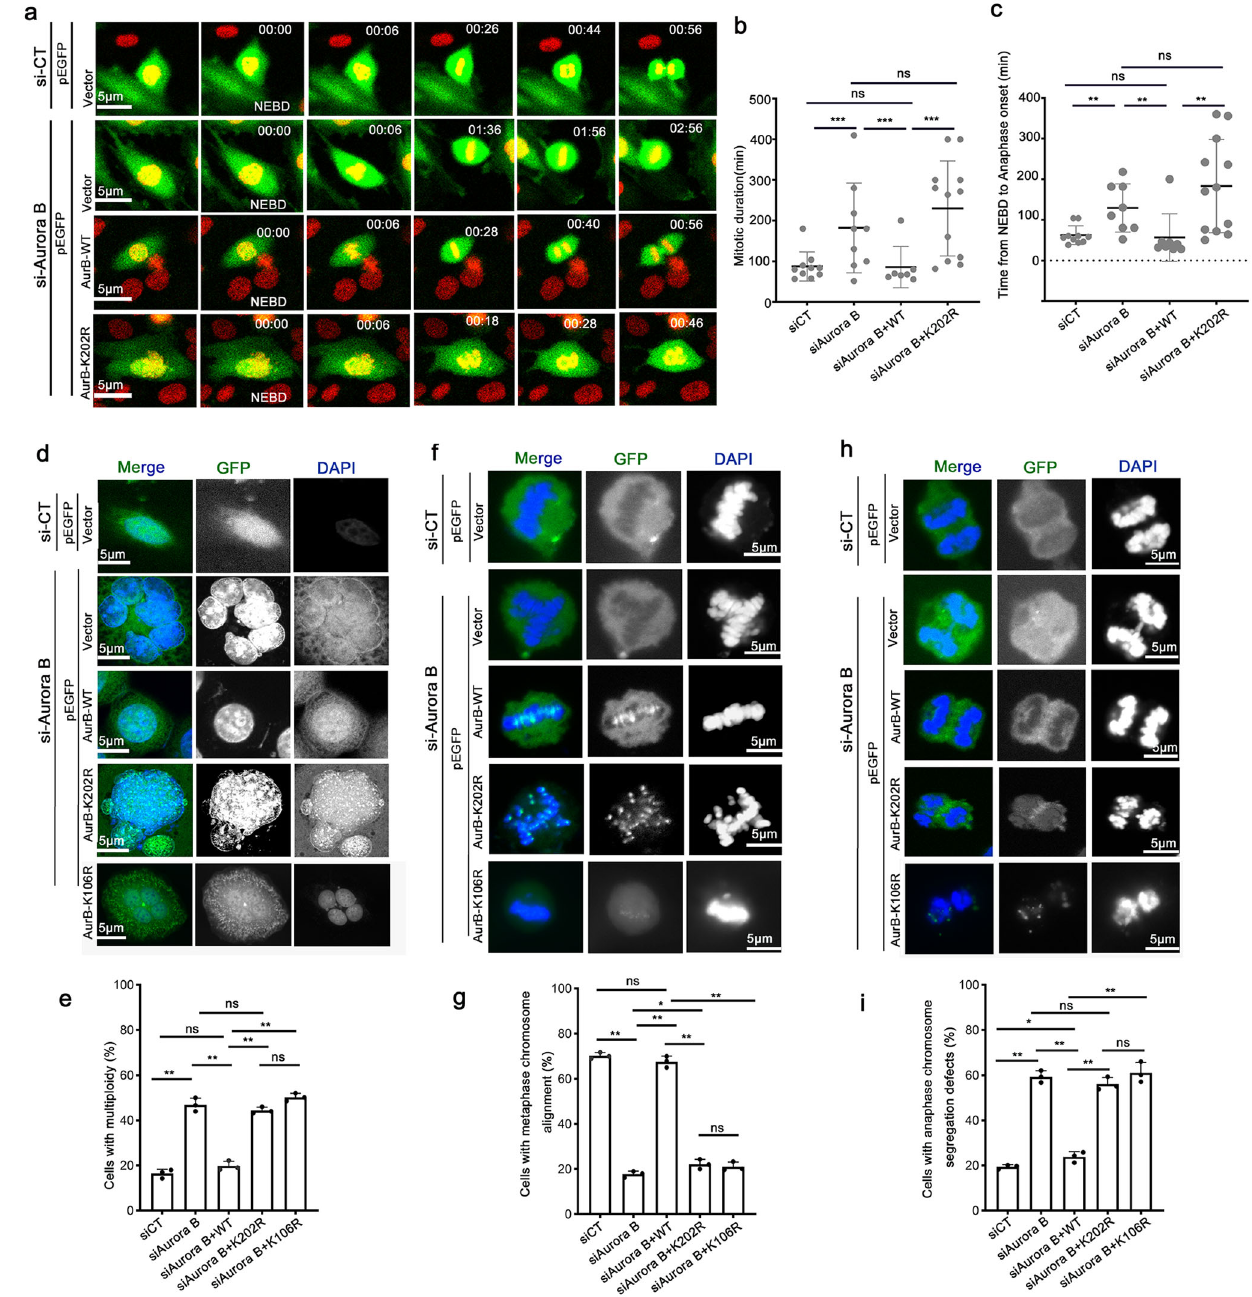
Fig. 6 Ubiquitination of Aurora B at Lys202 is required for proper mitotic progression. a Representative live-cell still images of dividing mCherry-H2B HeLa cells co-transfected with siAurora B and pEGFP-vector control, pEGFP-Aurora B or pEGFP-Aurora B-K202R, respectively. Bars, 5 µ m. NEBD indicates the fi rst frame after nuclear envelope breakdown, based on the chromatin marker mCherry-H2B. Times are shown in hours: min. mCherry-H2B HeLa cells transfected with the indicated plasmids were synchronized by RO-3306 (9 μ M) for16 h and then released into a fresh medium. Live-cell confocal time- lapse images were taken at the indicated time points. b Quanti fi cation of the mitotic duration cells spent from NEBD to mitosis completion. ** p < 0.01 c Quanti fi cation of the time course cells spent from NEBD to anaphase onset. ** p < 0.01. Each dot represents an individual cell. d Representative images of multi-nuclei defects in post-mitotic cells co-transfected with siAurora B and pEGFP-vector control, pEGFP-Aurora B, pEGFP-Aurora B-K202R or pEGFP- Aurora B-K106R, a known kinase inactive mutant. Bar, 5 μ m. e Quanti fi cation of th e cells with multi-nuclei defects shown in d . Data are shown as means ± SD, n = 3 biological replicates. In each independent experiment, 30 cells were analyzed. f – i The effects of Aurora B-K202R mutant on KT-MT error correction. Representative confocal images showing metaphase chromosome alignments ( f ) or anaphase chromosomes segregation ( h ) in cells transfected with the indicated plasmids as described in d . HeLa cells were synchronized by monastrol (50 μ M) and released into a fresh medium for 30 or 45 min. Bar, 5 μ m. g Quanti fi cation of the cells with aligned chromosomes at metaphase shown in f . Data are shown as means ± SD, n = 3 biological replicates. In each independent experiment, 20 cells were analyzed. i Quanti fi cation of the cells with chromosome segregation defects at anaphase, shown in h . Data are shown as means ± SD, n = 3 biological replicates. In each independent experiment, 16 cells were analyzed. ** p < 0.01 versus CT, Student ’ s t -test.